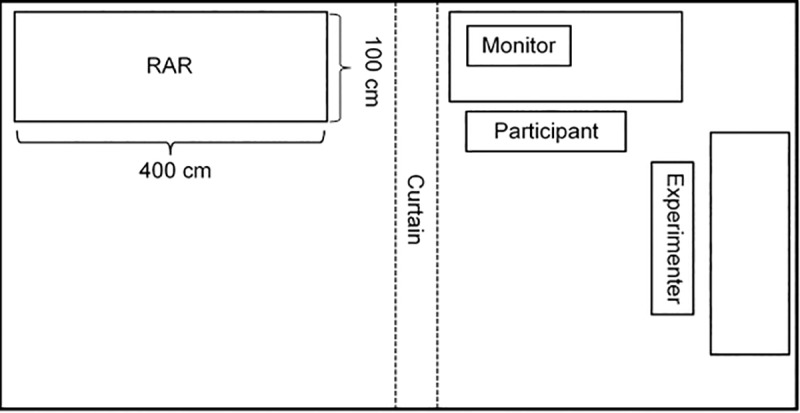
Laboratory setting.